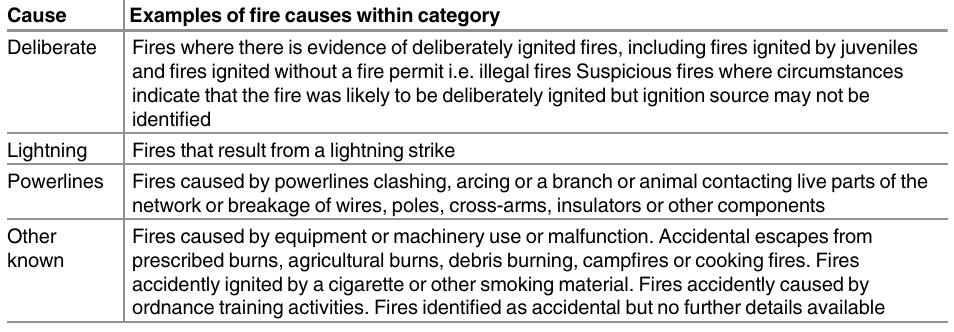
Table 1. Description of cause categories used for wildfire ignitions in the 12 year period.